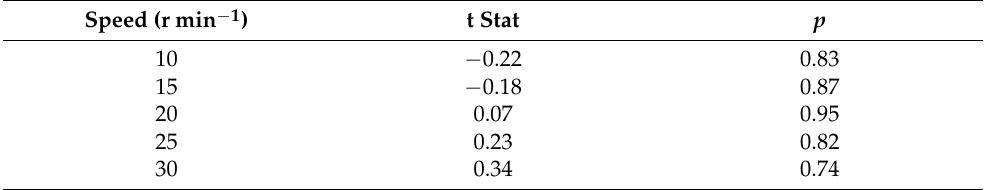
Table 3. Results of independent sample t -test for the average amount of fertilizer dispensed from the left and right fertilizer